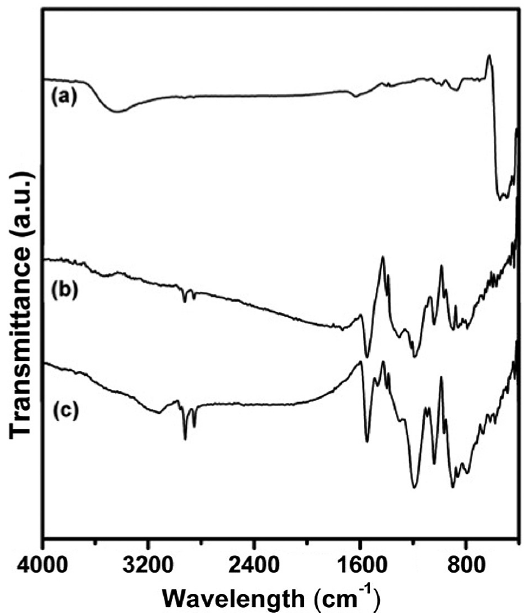
Figure 3. FTIR spectrum of: (a) ZnO_NPs, (b) PPy and (c) ZnO_NPs/PPy.